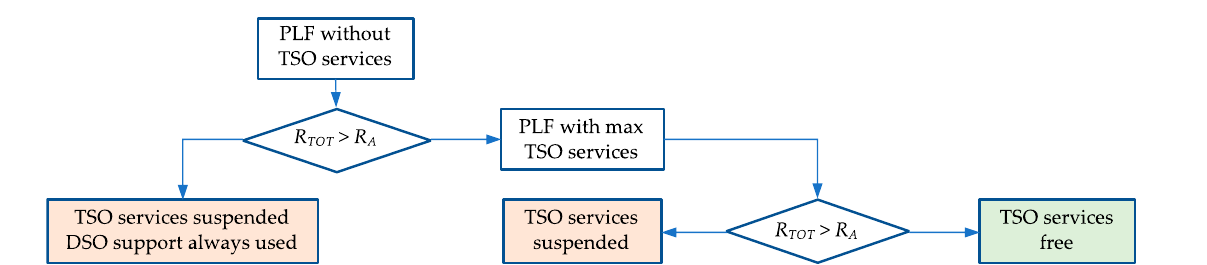
Figure 4. Identification of existing limitation in providing TSO services due to technical constraints violation in ordinary operating conditions.